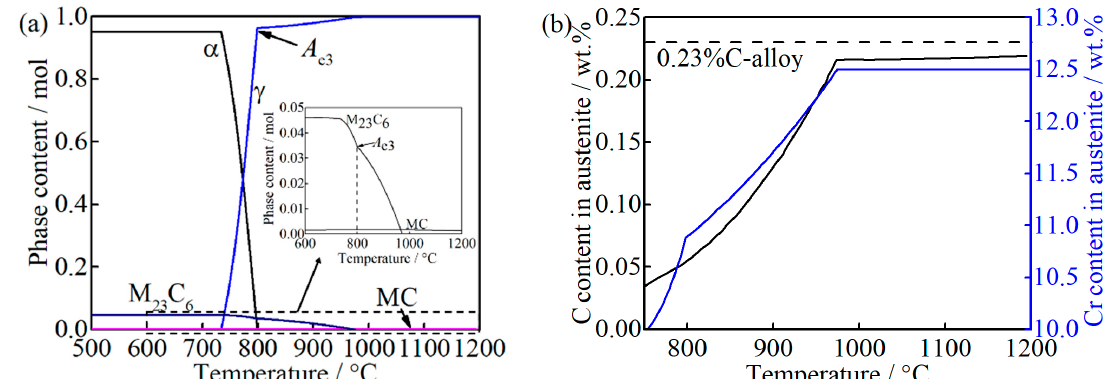
Figure 1. Thermodynamic calculations of ( a ) the equilibrium phases diagram; ( b ) the carbon and chromium content in austenite as a function of temperature, where “M 23 C 6 ” represents (Cr, Fe) 23 C 6 , and “MC” represents (Nb, Ti) C.